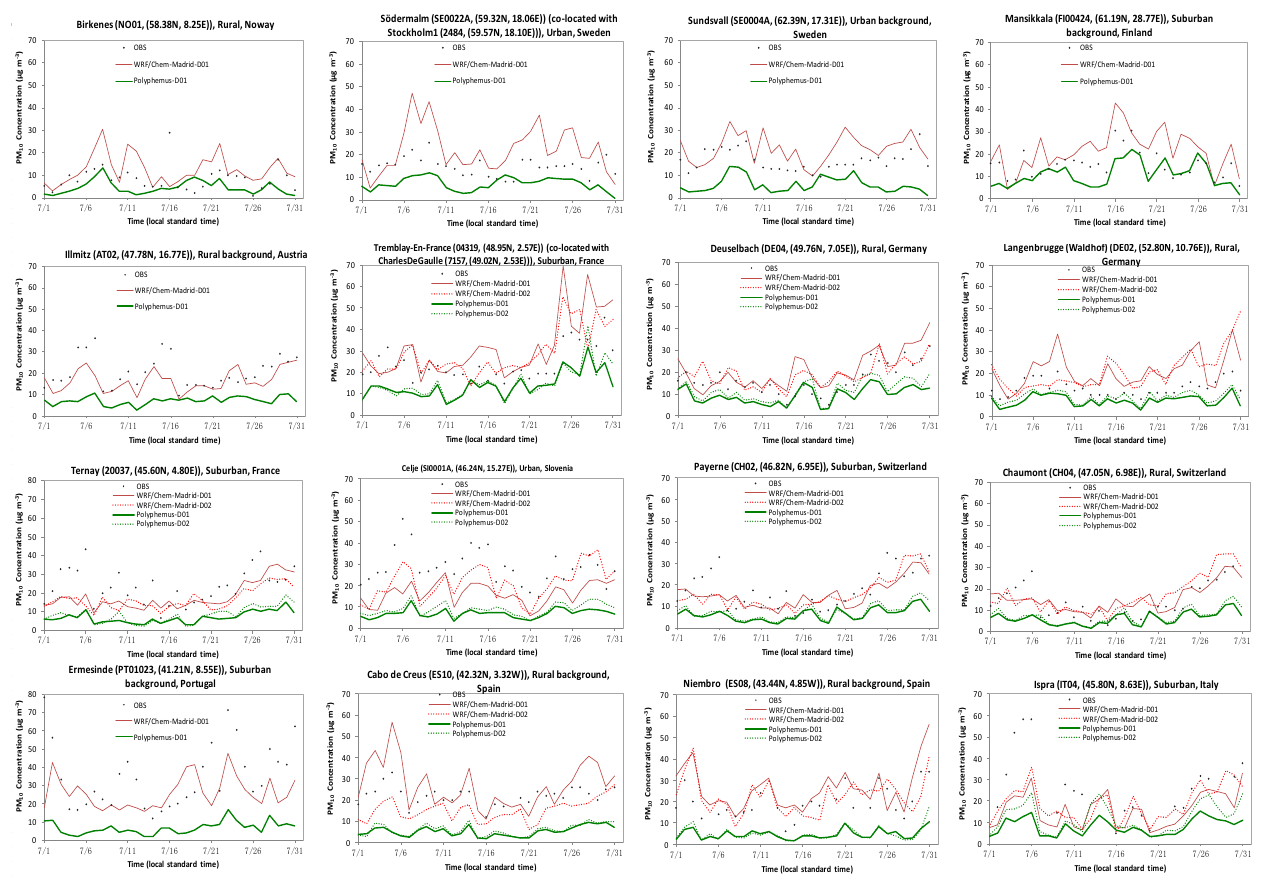
Figure 8. Simulated and observed concentrations of 24-hr average PM 10 at July 2001 selected sites over D01 and D02 in four latitude bands: 57-60 ºN, 48-52 ºN, 45-48 ºN, and 38-43 ºN (rows 1, 2, 3, and 4, respectively).